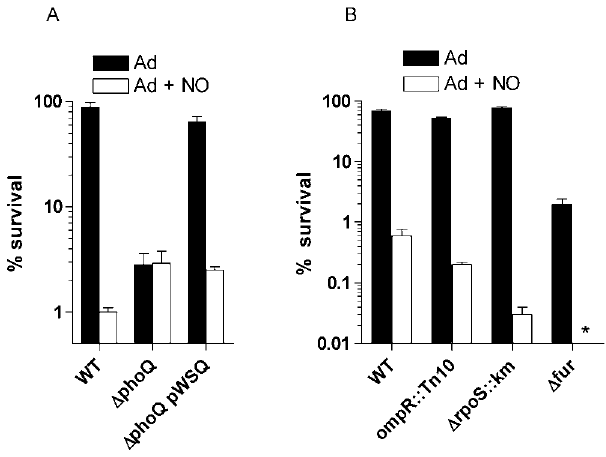
Figure 7. Acidified RNS suppress the PhoPQ-dependent ATR. Killing of wild-type Salmonella and its isogenic D phoQ::FRT control in EG medium, pH 3.0 is shown in panel A. The D phoQ::FRT mutation was complemented with a wild-type allele expressed from pWSQ. Selected groups of bacteria were treated with 250 m M spermine NONOate (Ad + NO) during the adaptation in EG medium, pH 4.4. Panel B compares the acid sensitivity of Ad and Ad + NO groups of Salmonella strains isogenic for D rpoS::km , ompR::Tn10 and D fur::FRT . The data represent the mean 6 SEM of 6–9 independent observations from 2–3 separate experiments. *, p , 0.05 compared to adapted controls. * *, no viable cells were detected after the adapted + NO group was challenged for 1 h in EG medium, pH